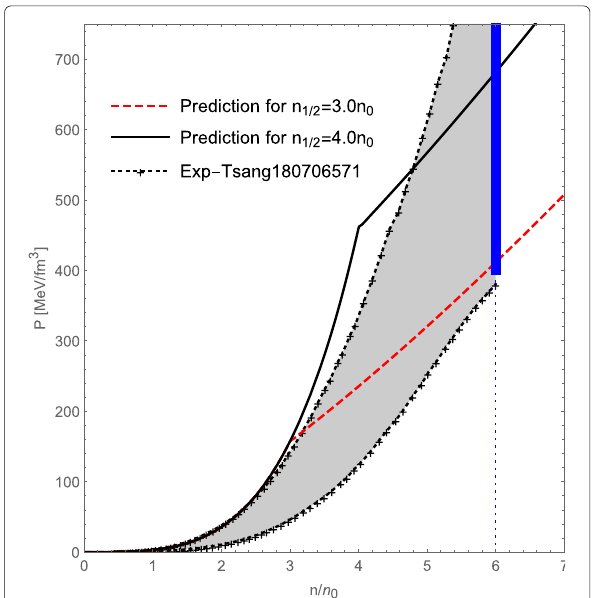
Fig. 7 Predicted pressure for neutron matter ( α = 1) vs density compared with the available experimental bound (shaded) given by Ref. [80] and the bound at 6 n 0 (blue band)